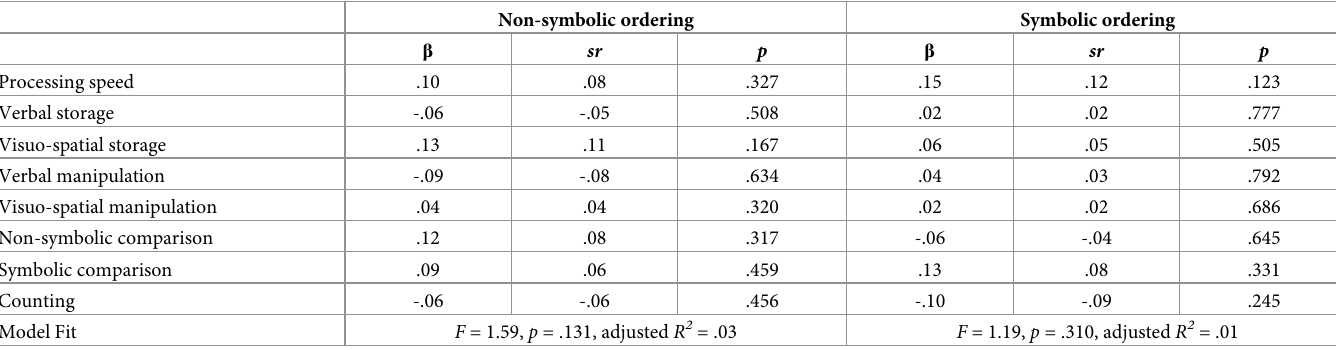
Table 6. Linear regression analyses predicting change in non-symbolic and symbolic ordering from Grade 2–3 by processing speed, working memory storage and manipulation, non-symbolic and symbolic comparison, as well as